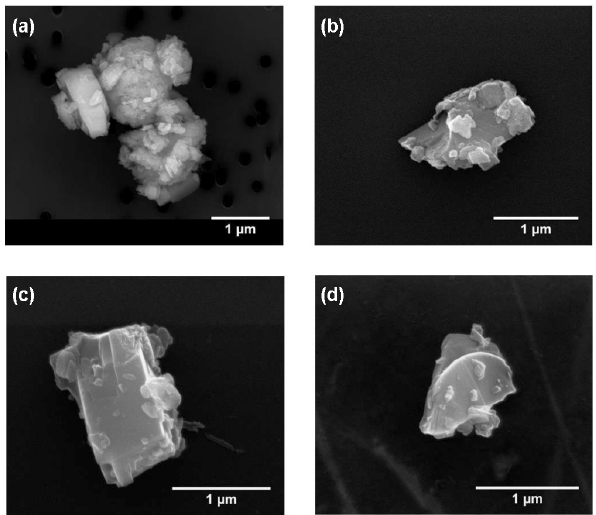
Figure 2. SEM images of (a) FS01, (b) FS02, (c) FS04, and (d) FS05 particles.